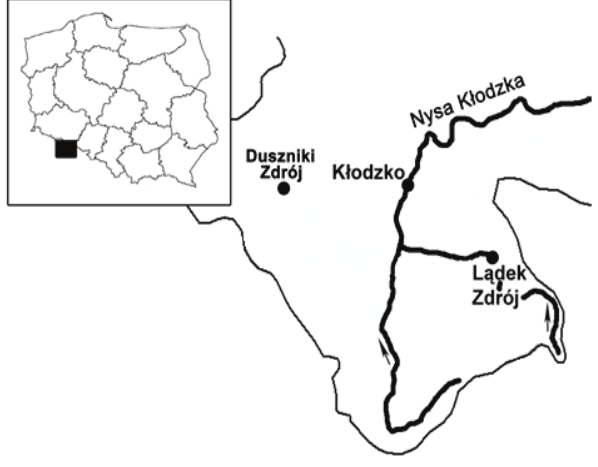
Fig. 1a. Location catchment in the Kłodzko Valley area (SW part of Poland) [2], [6], [14]